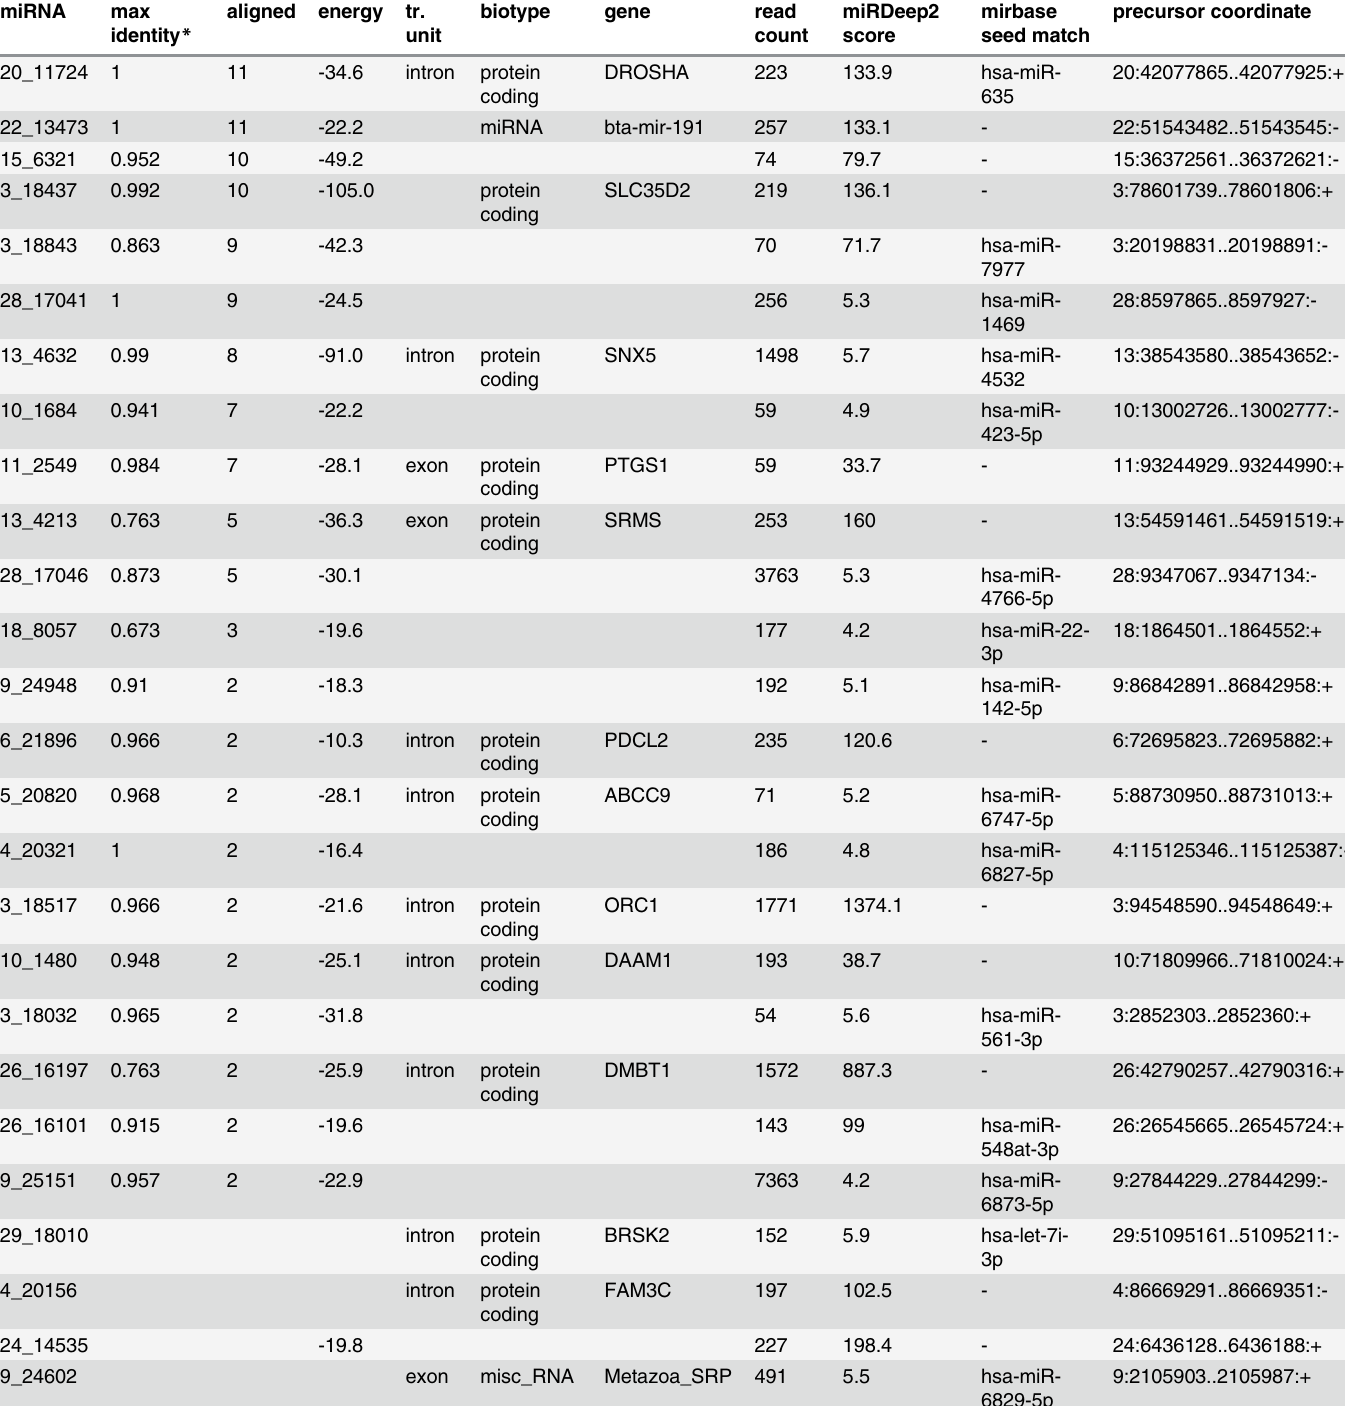
Table 2. Novel micro RNAs predicted in the data by mirDeep2 (after filtering steps). The 'gene' column denotes a host gene where found with transcrip- tion unit (intron or exon). The table is sorted by conservation in mammal species, that is, the number of species with aligned orthologs (aligned column). tr. unit = transcription unit. * max identity is the highest sequence identity to another